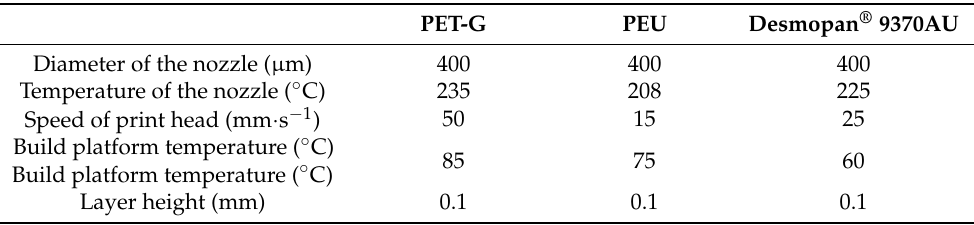
Table 1. Printing parameters selected for additive manufacturing with different